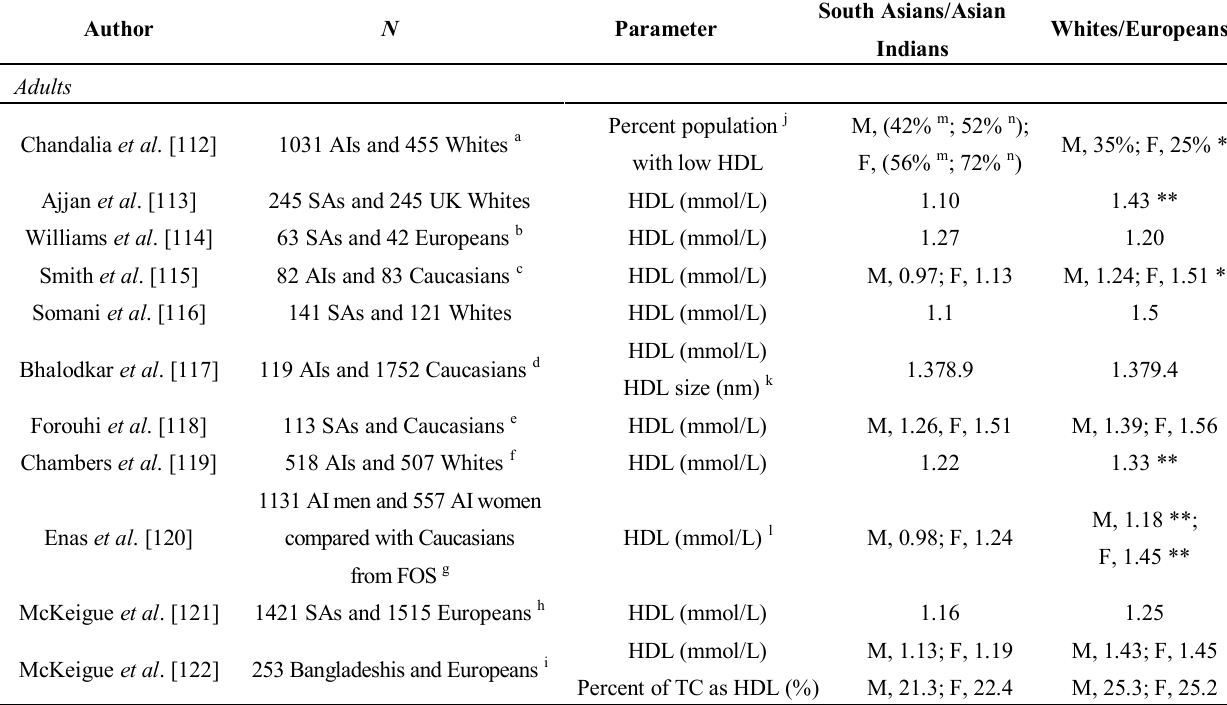
Table 5. Differences in the high-density lipoprotein cholesterol (HDL) levels between South Asians/Asian Indians vs . Whites/Europeans. Note: this table is reproduced with permission from [27]. Copyright The Endocrine Society,